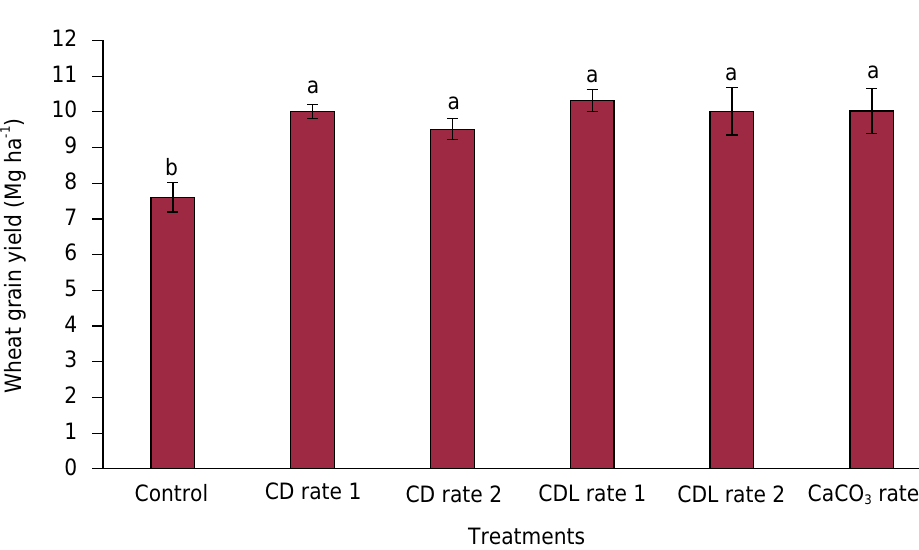
Figure 3. Wheat grain yield at Osorno in response to six treatments of soil acidity control. Different letters over the bars indicate differences between treatments according to Tukey’s test (p<0.05). Lines over the bars indicate standard error. AD: Boiler ash + dregs; ADS: Boiler ash + dregs + lime sludge; Rate 1: CaCO 3 reference rate; Rate 2:2 × rate 1.